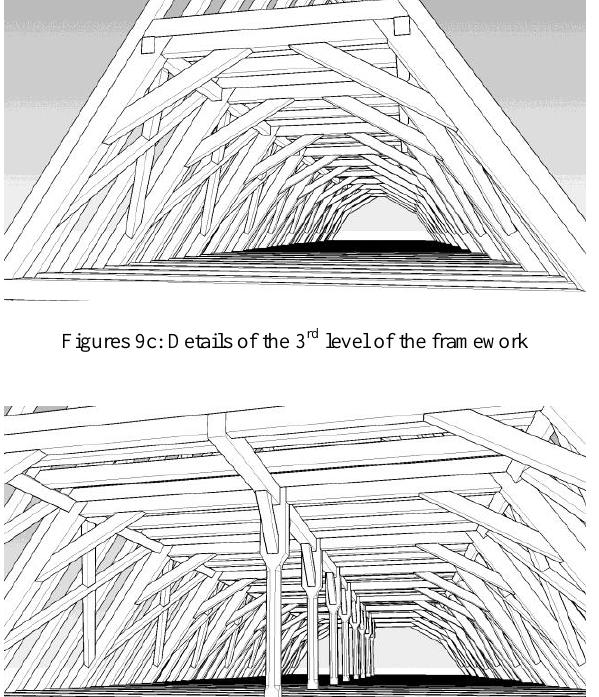
Figure 8: Modelling process